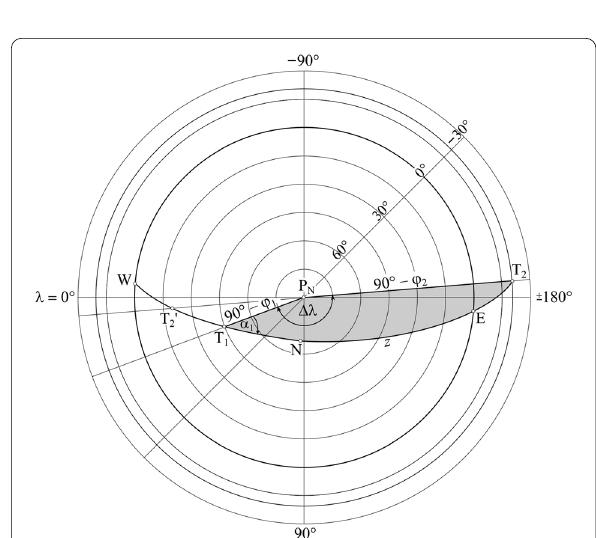
Fig. 3 View of part of the Earth’s globe (up to the parallel φ shown in the polar. Postel projection T 1 is Belgrade, T 2 is Hunga Tonga volcano, and T 2 ’ is the antipode of point T 2